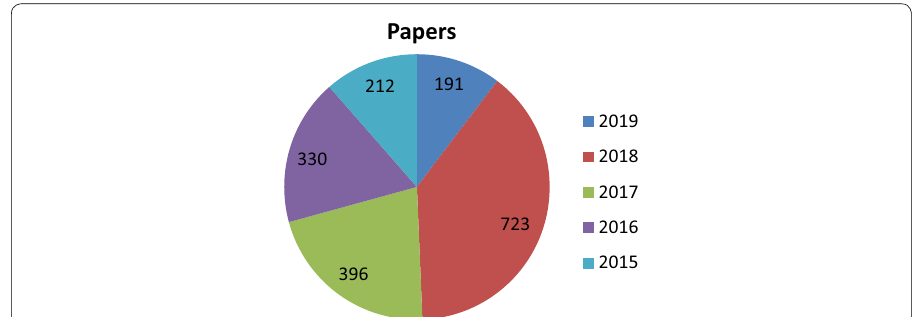
Fig. 1 Year wise paper statistics of “surveillance video analysis by deep learning”, in ScienceDirect